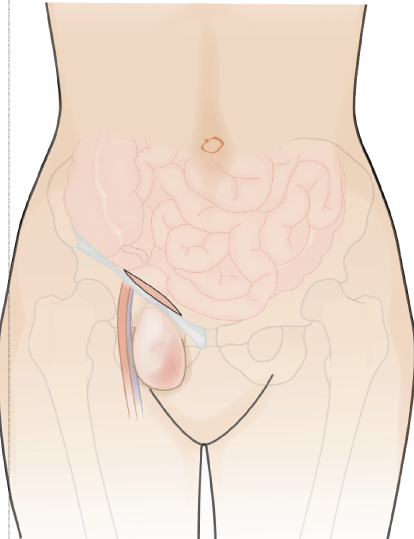
Figure 1: The skin incision is placed parallel and slightly above the inguinal ligament.